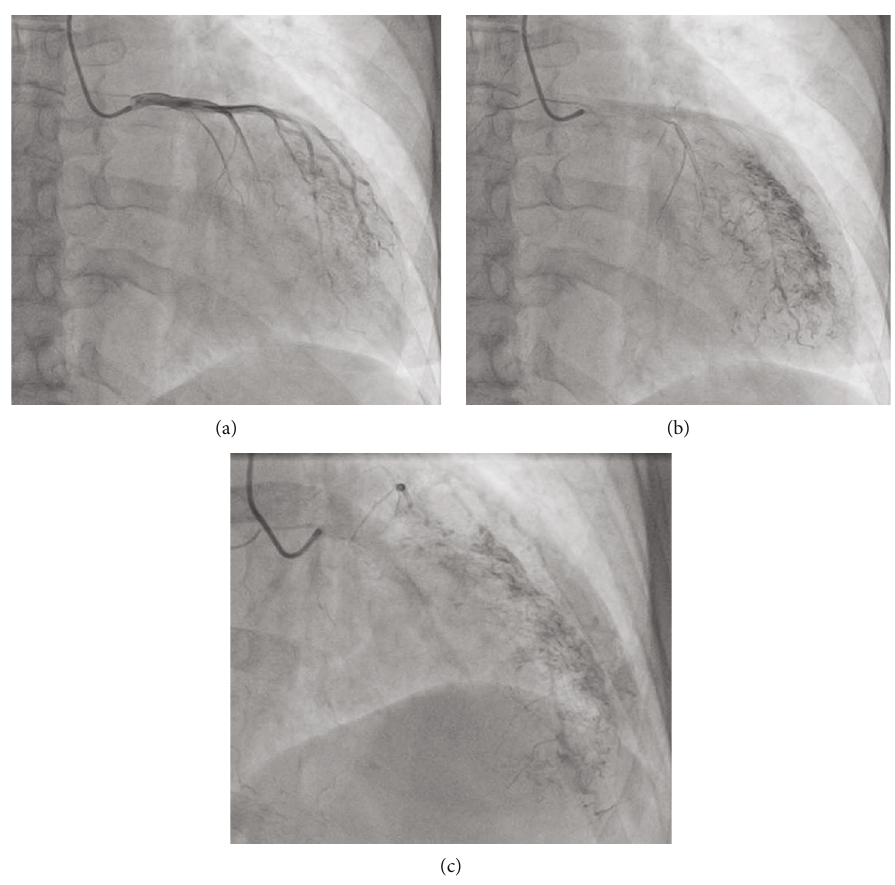
Figure 2: (a) Left coronary artery. (b and c) Multiple micro fi stulas draining in the left